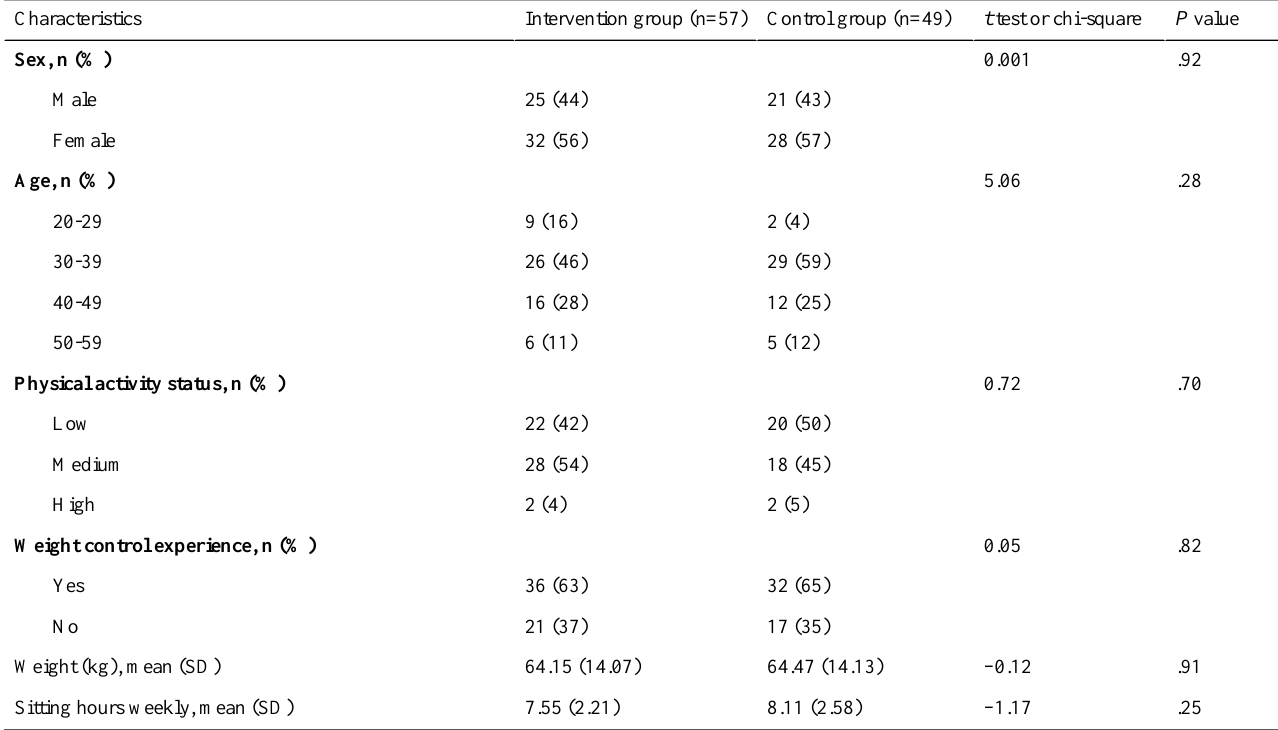
Table 1. Homogeneity test of general characteristics at